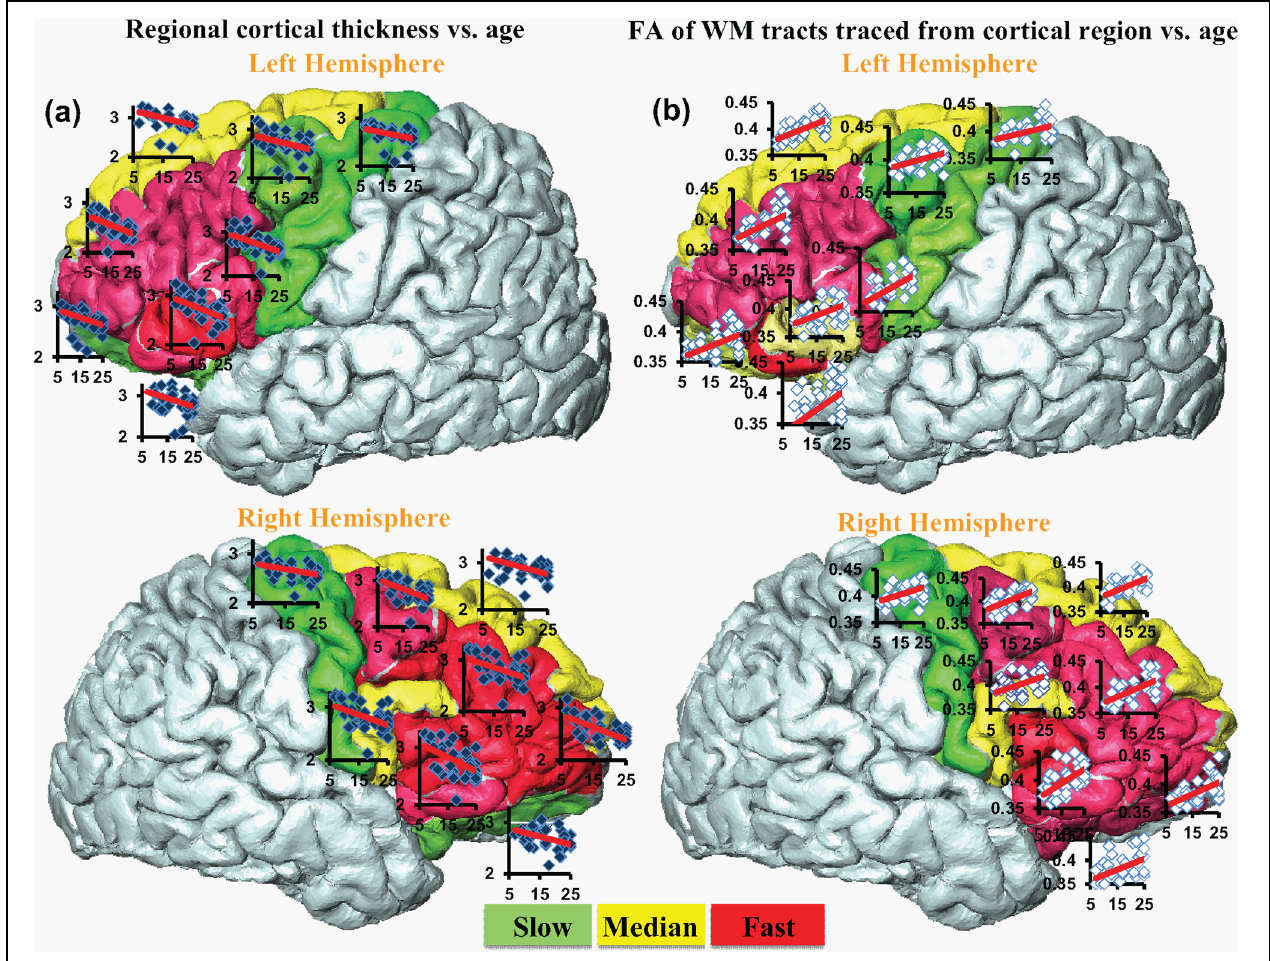
FIGURE 4 | The coherent CT decrease rate (a) and corresponding WM FA increase rate (b). Each cortical region is encoded by the change rate and categorized into slow (green), median (yellow) and fast (red) from smallest to largest. Scatter plots for regional CT vs. age (blue dots) and corresponding FA vs. age (white dots) are overlaid on the individual